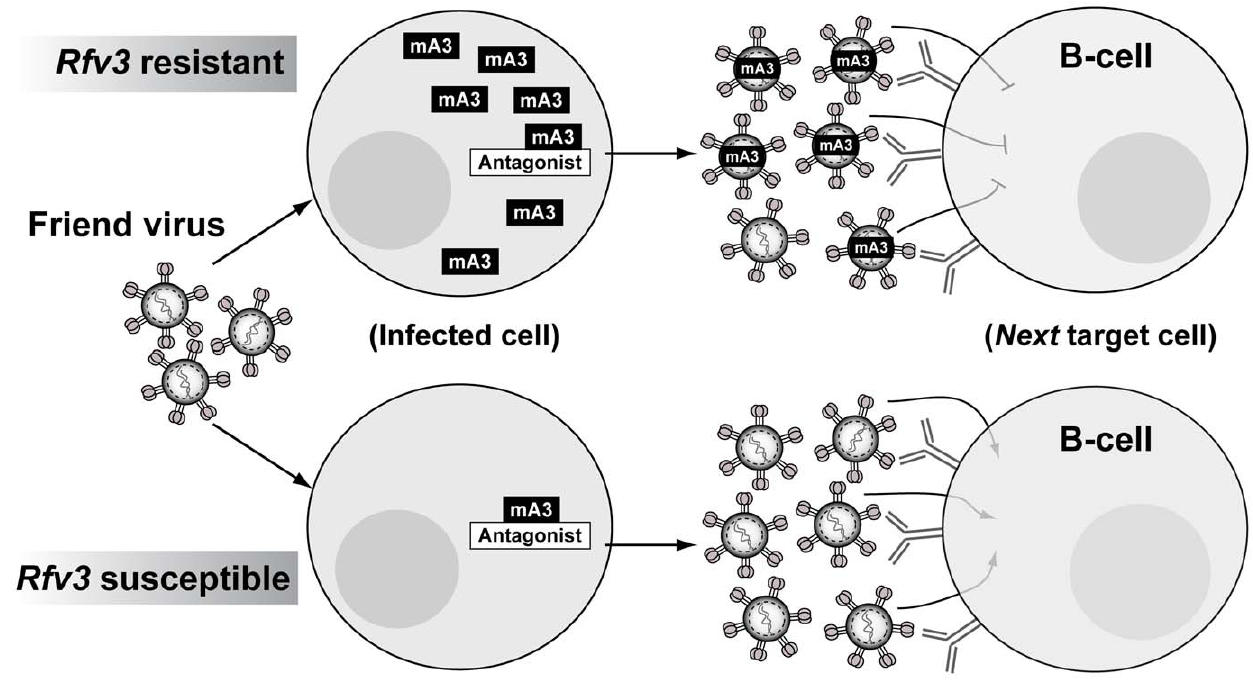
Figure 5. Model for mA3 action and FV-specific humoral immunity. In Rfv3 resistant mice, high endogenous levels of mA3 may overwhelm putative FV-encoded antagonists such as Glyco-Gag, [57] resulting in functional mA3 incorporated into budding virus particles. In contrast, low levels of mA3 in Rfv3 susceptible strains could efficiently be inactivated. In both strains, similar levels of virus particles released during acute infection could facilitate antigen-specific B cell development. However, virions derived from Rfv3 resistant strains encounter an early post-entry reverse transcription block in target cells. Thus, antibody affinity maturation can occur against functional envelope trimers with decreased pathology in Rfv3 resistant mice. In contrast, fully infectious virions from Rfv3 susceptible strains could directly infect B cells (and other immune cells), resulting in immune dysfunction and weaker development of NAbs. We hypothesize a similar scenario during acute HIV-1 infection, except that: (1) the antagonist is HIV-1 Vif, which degrades hA3G/hA3F; and (2) the targets are CD4 + T cells, which in germinal centers are in direct contact with and provide help for antigen-specific B cell development.